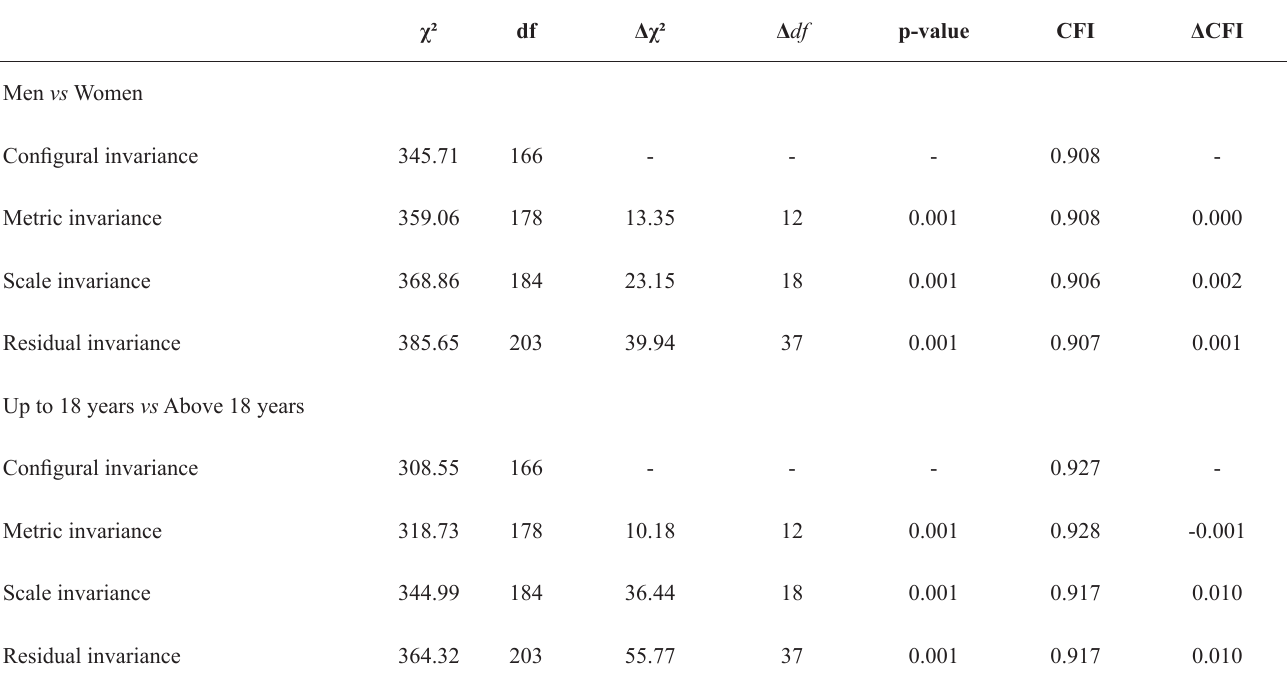
Table 2 - Goodness-of-fit indexes for the invariance of the modified model with 15 items (M2) of the Brazilian version of ABQ χ² df